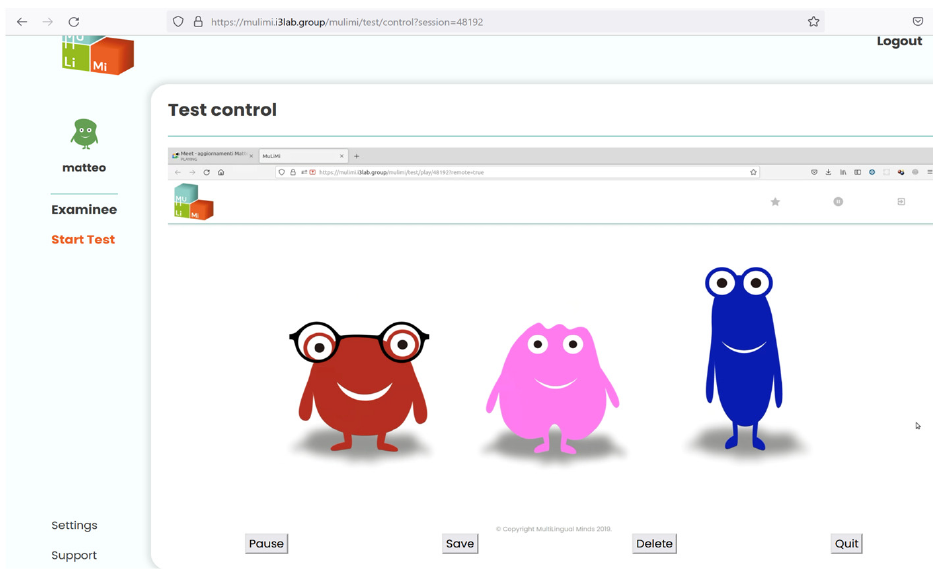
Figure 2. Examiner interface during remote administration of the DNWL consolidation phase.